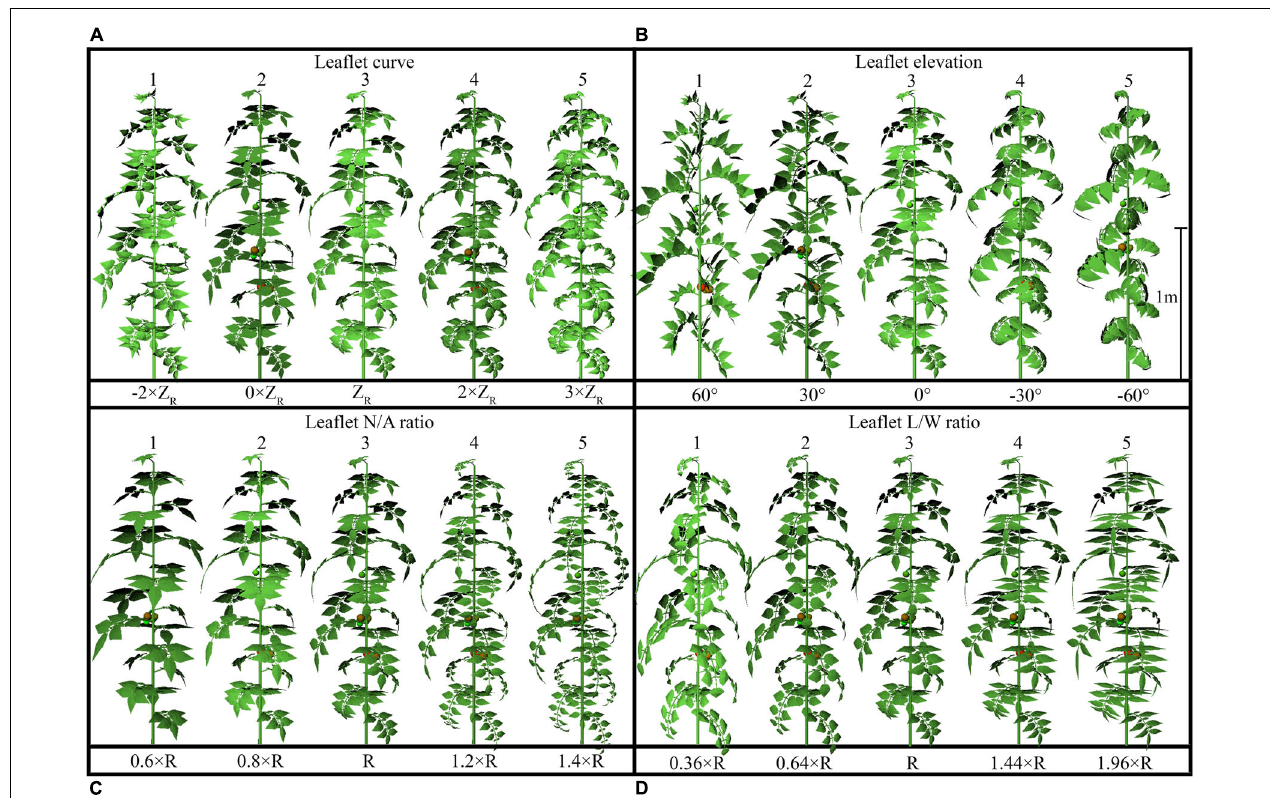
FIGURE 4 | Detailed configurations of the plant architectural traits. Each plant architecture group was simulated individually with five adaptations for each scenario. Each adaptation was applied to every leaf rank of tomato plant, with visual 3D representation of each leaf-level adaptation, namely: leaflet curve (–2 × Z R , 0 × Z R , Z R , 2 × Z R , 3 × Z R ) (A) , leaflet-elevation angle (60, 30, 0, –30, –60 ◦ ) (B) , leaflet number/area ratio (0.6 × R, 0.8 × R, R, 1.2 × R, 1.4 × R) (C) , and leaflet length/width ratio (0.36 × R, 0.64 × R, R, 1.44 × R, 1.96 × R) (D) . Z R being the reference Z-axis value of each leaflet modeling point. The different leaflet curvature adaptations were achieved by changing the Z-axis value of each point and then rescaled according to the reference length of the